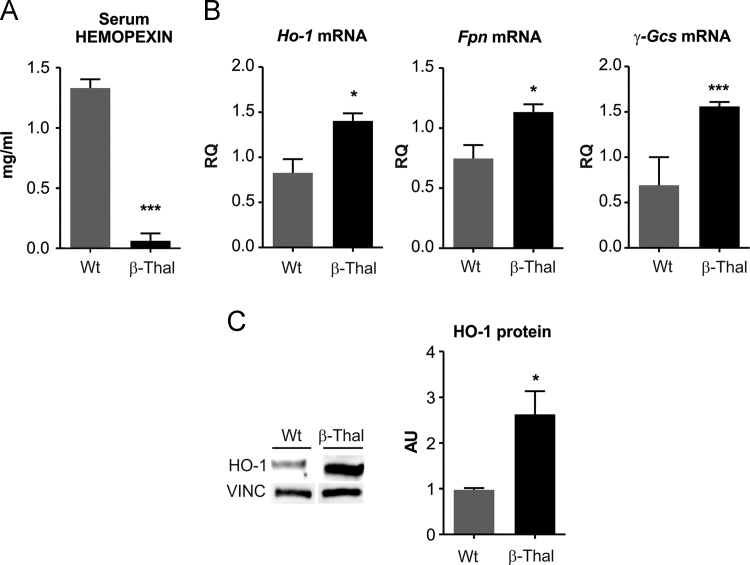
β-thalassemic mice are hemolytic and accumulate heme in the heart. Data on Wt and β-thalassemic (β-Thal) mice are shown. (A) ELISA quantification of serum Hx. (B) qRT-PCR analysis of Ho-1, Fpn and γ-Gcs mRNA levels in the heart. (C) HO-1 western blot analysis. Unpaired t-test analysis with Welch׳s correction was performed. ⁎P < 0.05; ⁎⁎⁎P < 0.001. Values represent mean ± SEM.